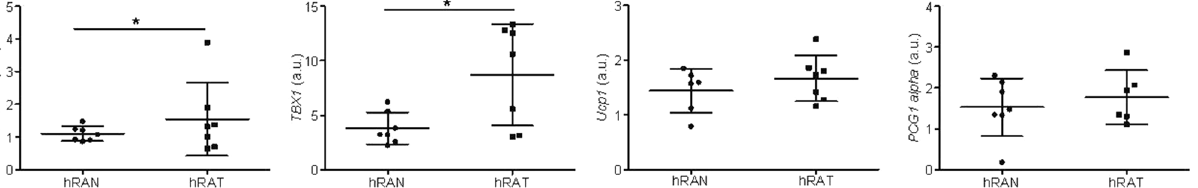
Figure 2. Relative fold expression of Prdm16, TBX1, Ucp1 and PGC1 alpha gene expression from hRAN and hRAT. The mRNA profiles of Prdm16, TBX1, Ucp1 and PGC1 alpha from different adipose tissue were analyzed by qRT-PCR and normalized by their relative ratio to GAPDH. Data are mean ± SEM. GAPDH, glyceraldehyde- 3-phosphate dehydrogenase. * p <